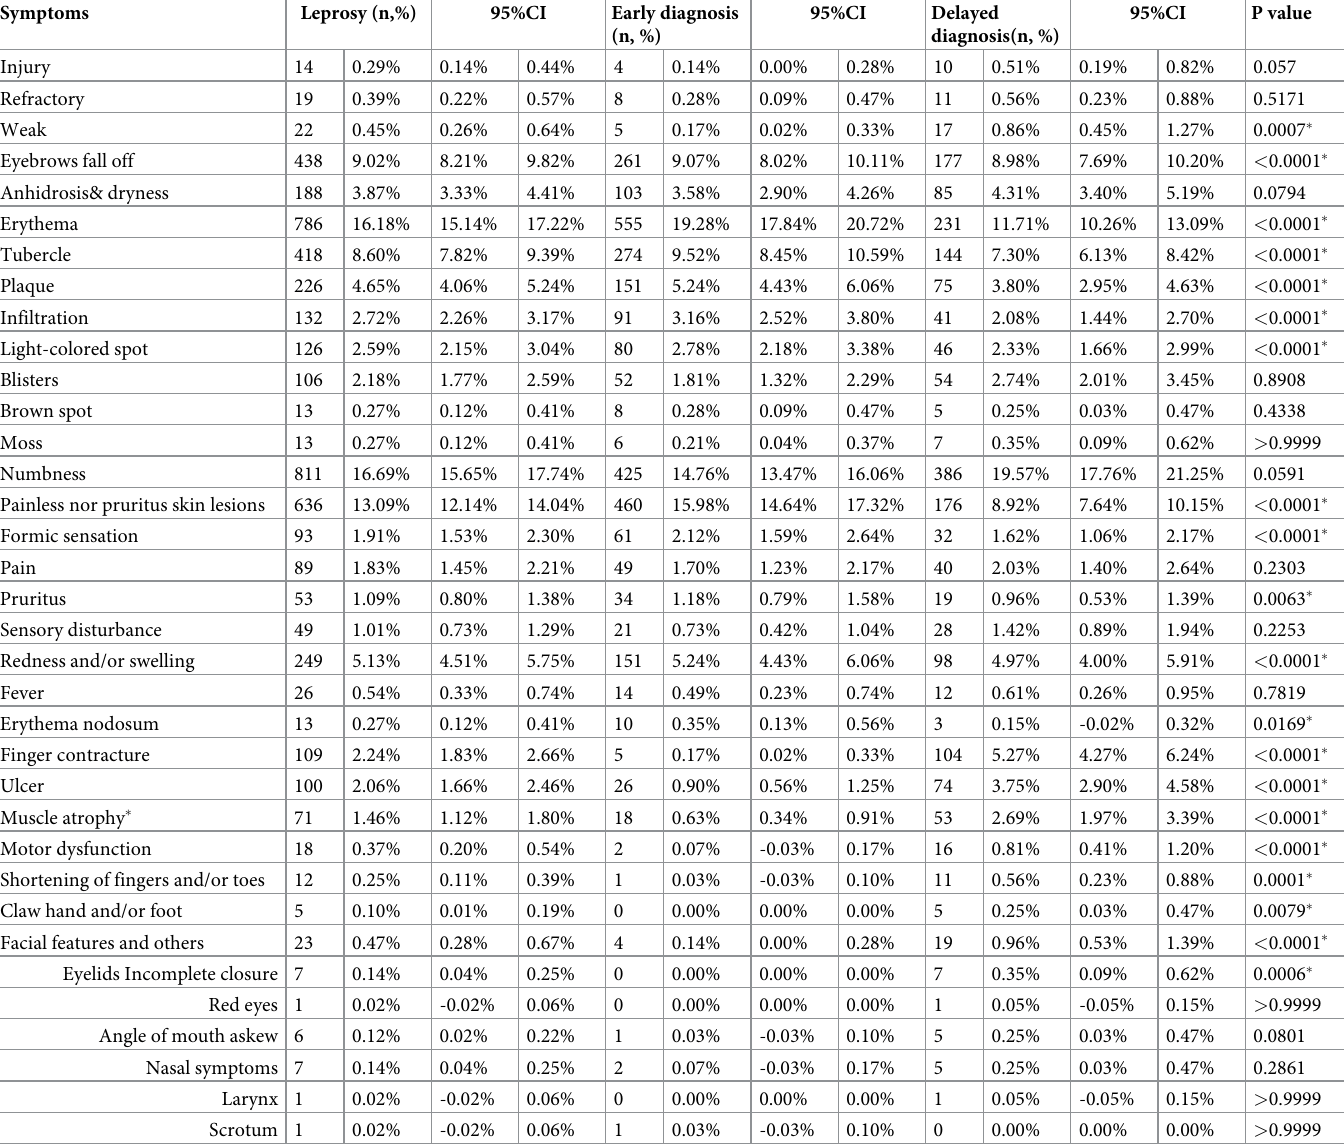
Table 5. Observed Proportions of Early Diagnosis and Delayed Diagnosis Associated with Presenting Symptoms in Newly Detected Leprosy Cases in Yunnan, China,